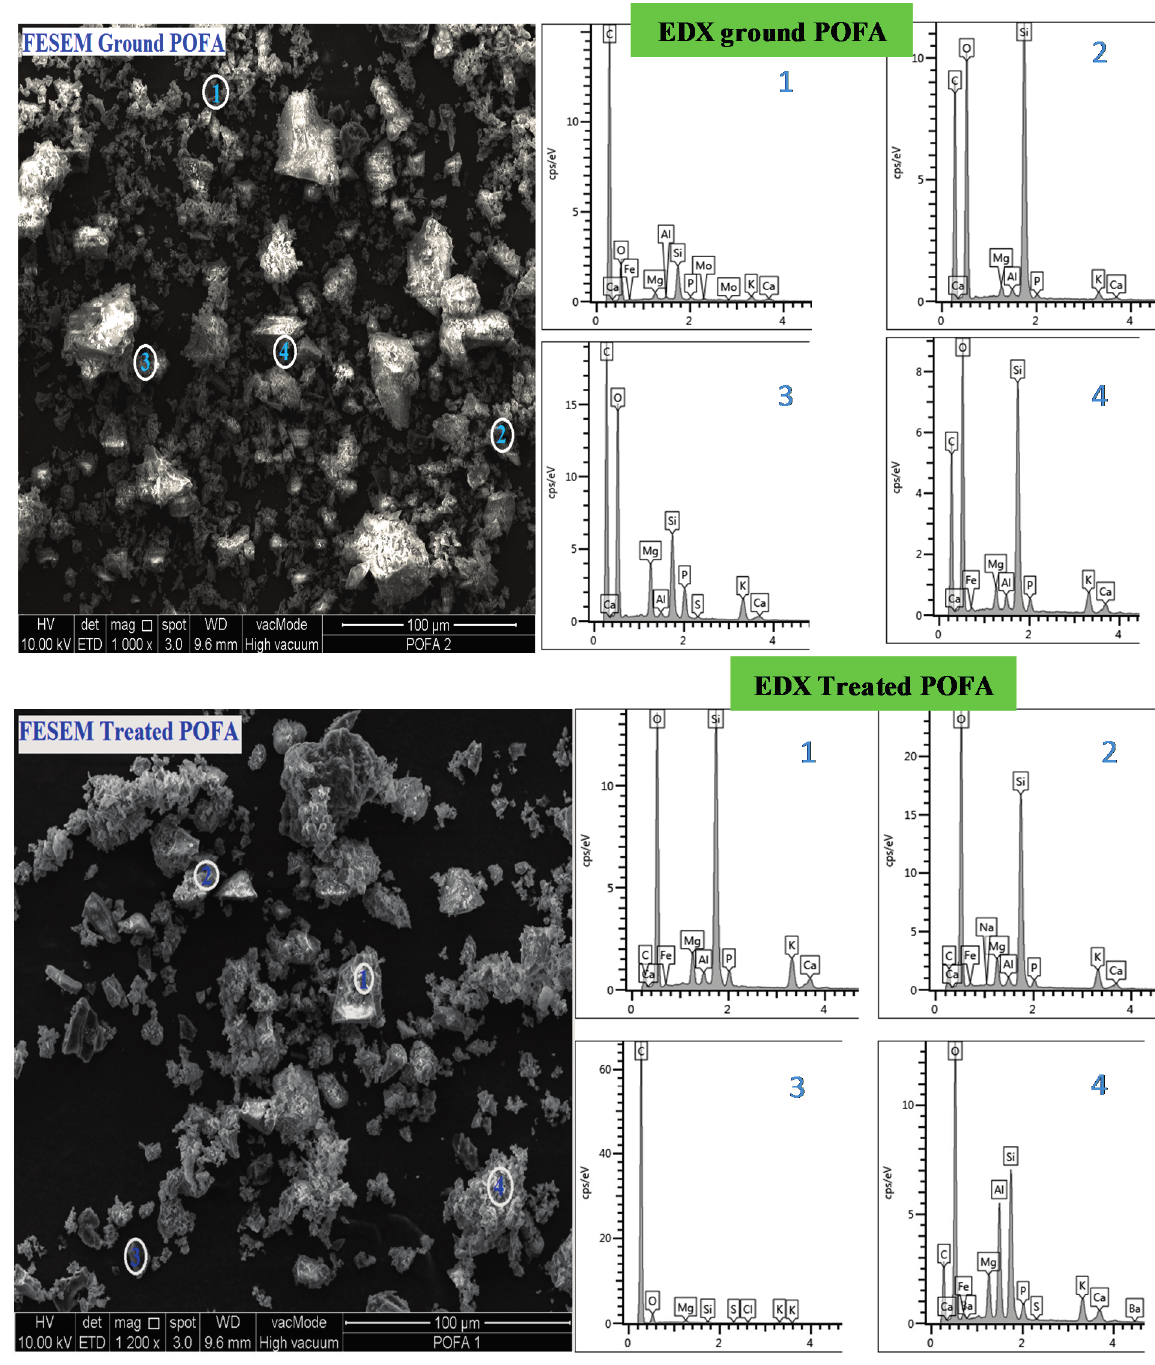
Figure 2. FESEM for ground POFA and treated